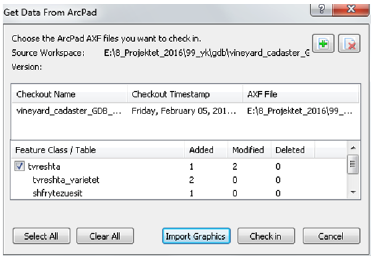
Figure 4. Device synchronization with the geodatabase